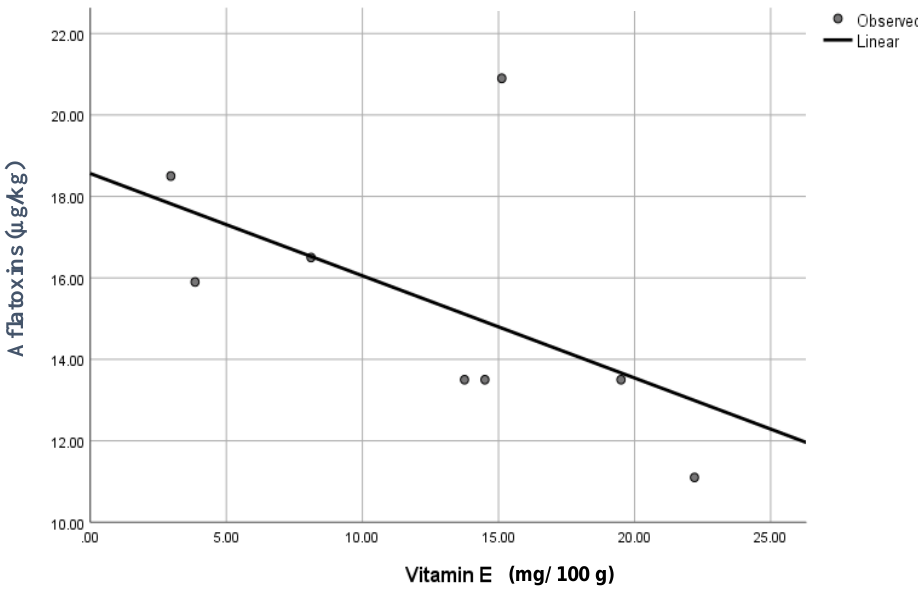
Figure 5. The correlation between vitamin E and total AFs concentrations.